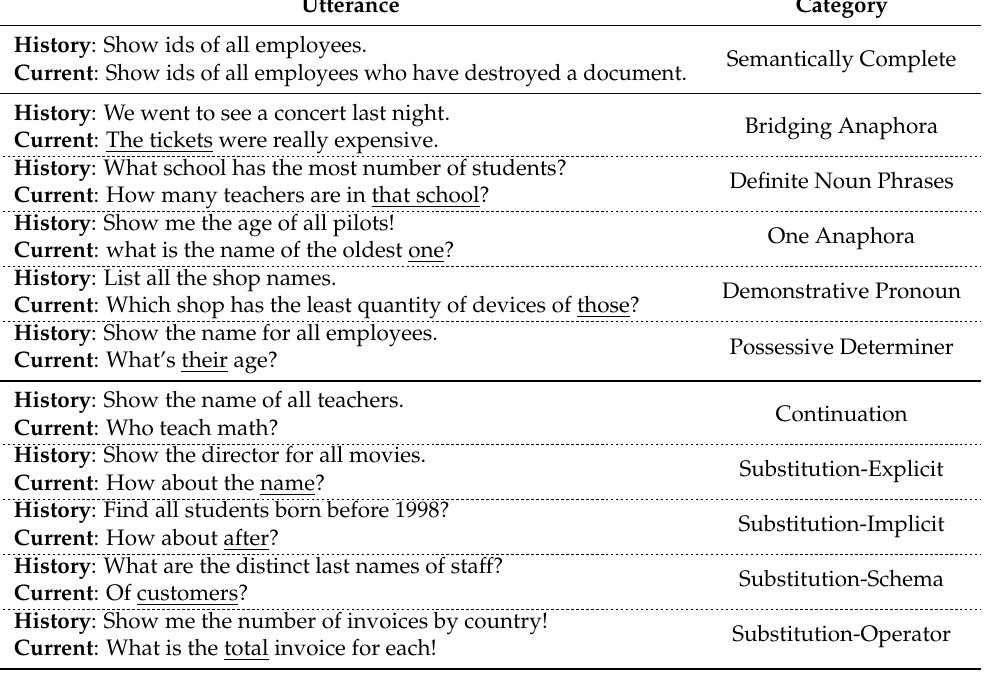
Table 1. Examples of all the semantic states. Utterance